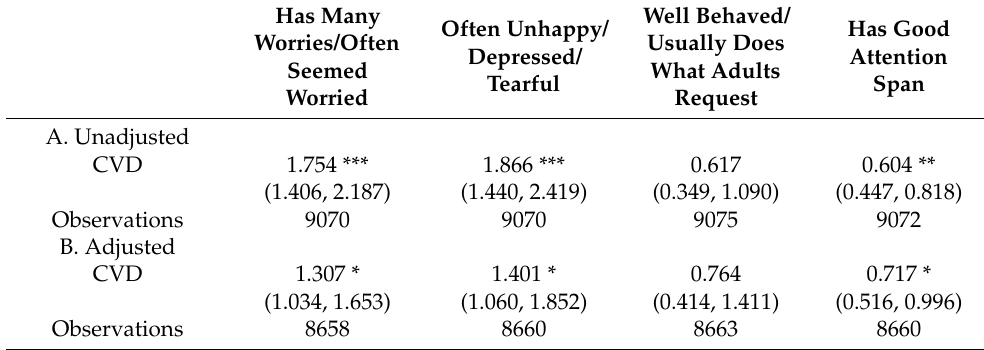
Table 4. Crude and adjusted odds ratios in favor of mental health indicators.